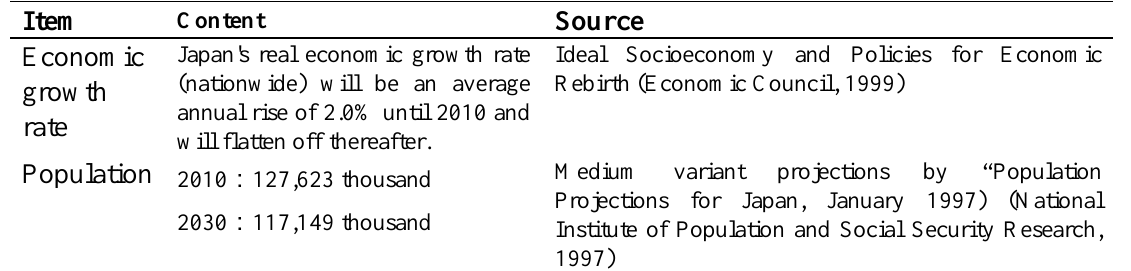
Table 4. Assumptions common to all scenarios (Japan as a whole)